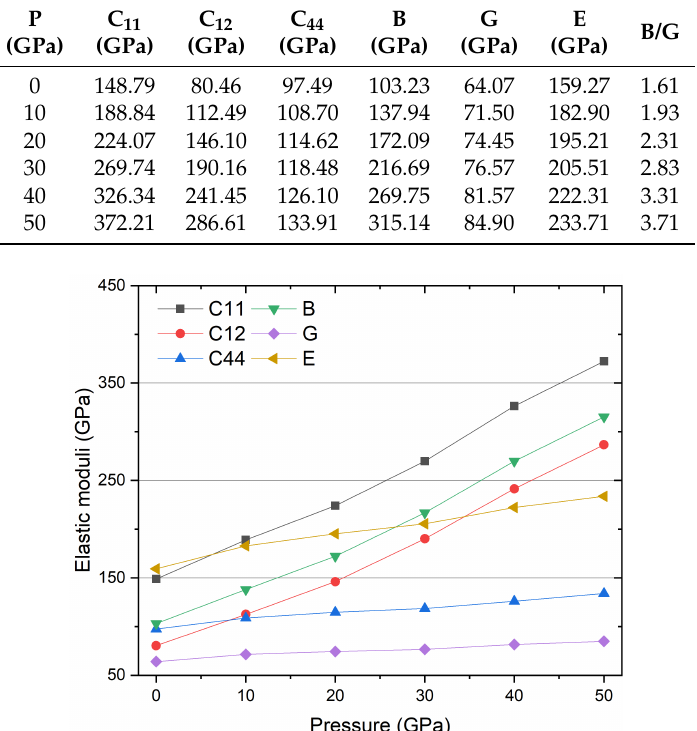
Figure 9. The elastic constants C ij , bulk modulus B, shear modulus G and Young’s modulus E of Ti 2 MnAl compound under different